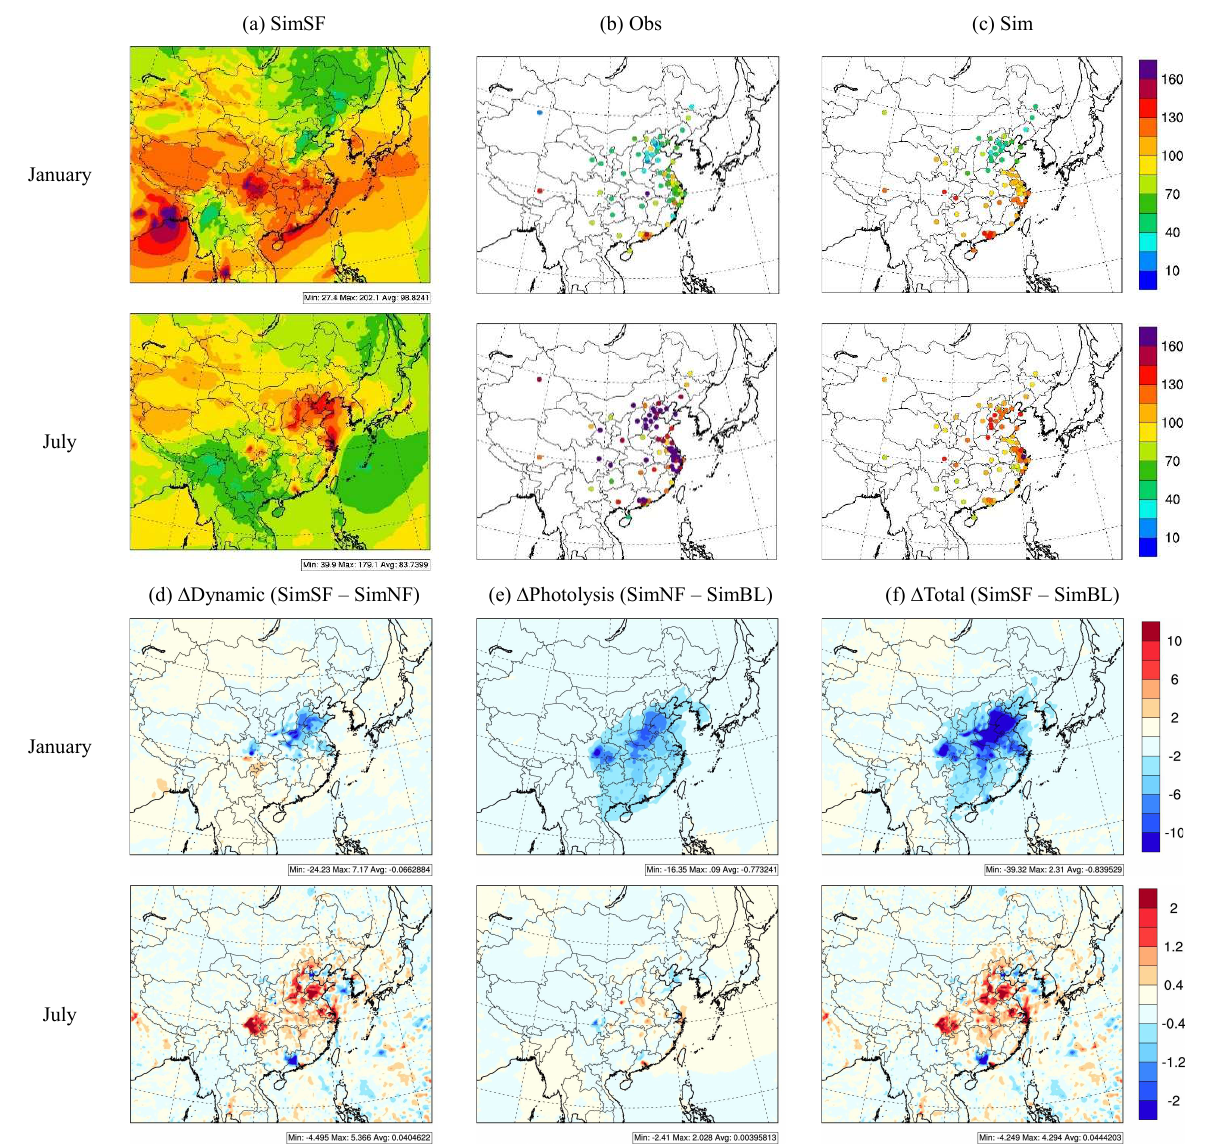
Figure 2. Observed and simulated O 3 and its response to ADEs (monthly average of daily 1h maxima, µgm − 3